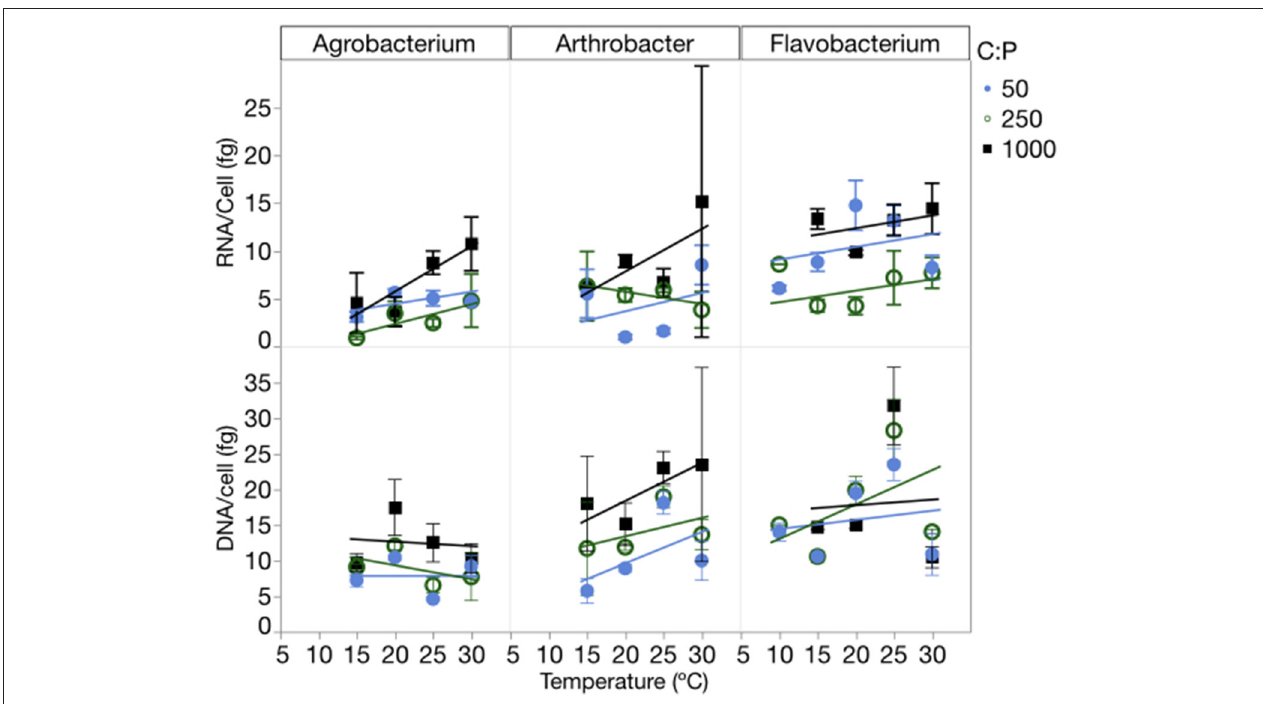
FIGURE 5 | Changes in the RNA and DNA content (fg cell − 1 ) of each strain across temperatures, with different symbols for each level of supply C:P. Error bars represent one standard error of the